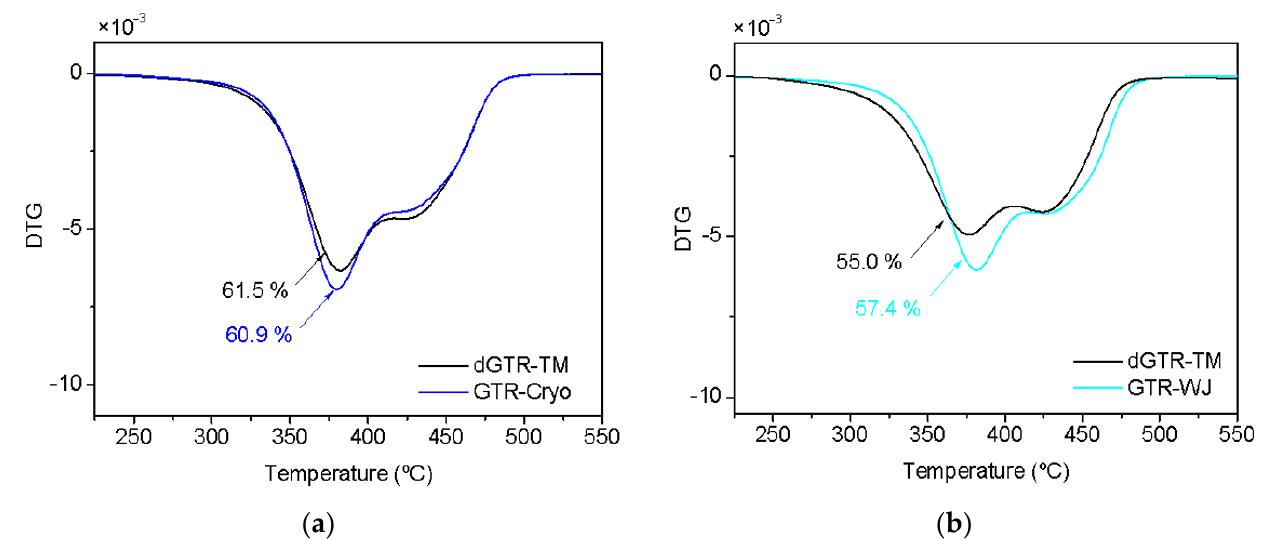
Figure 4. DTG curves of ( a ) GTR-Cryo, ( b ) GTR-WJ, and its dGTR-TM after extraction with acetone.